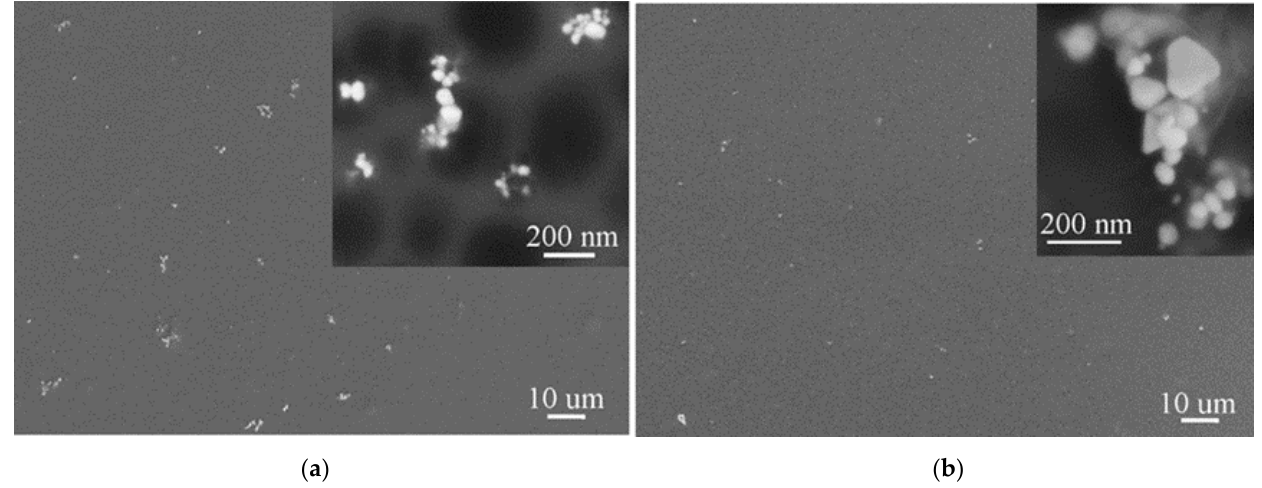
Figure 3. SEM images of ex situ ( a ) and in situ ( b ) PVA-5AgNPs thin layers with detailed view of AgNPs.